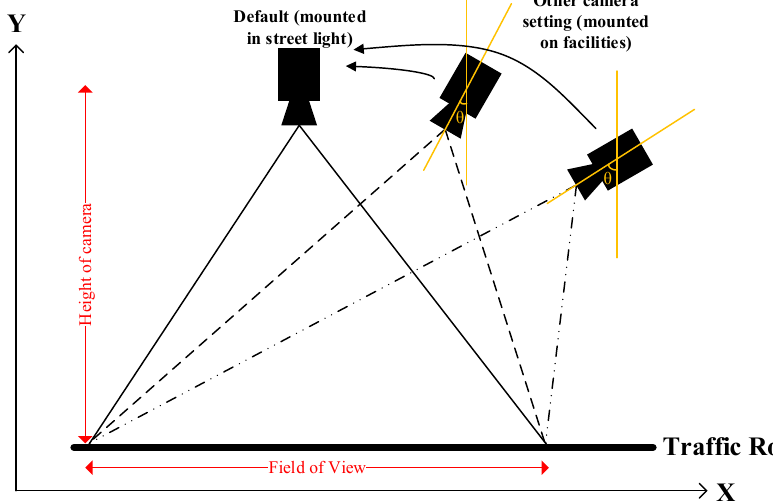
Figure 7. Illustration of various camera positions.